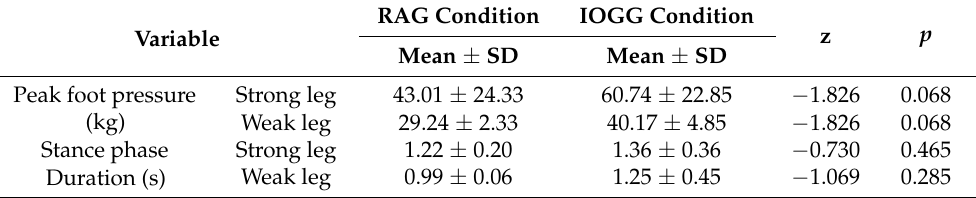
Table 2. Difference in foot pressure distribution between strong and weak